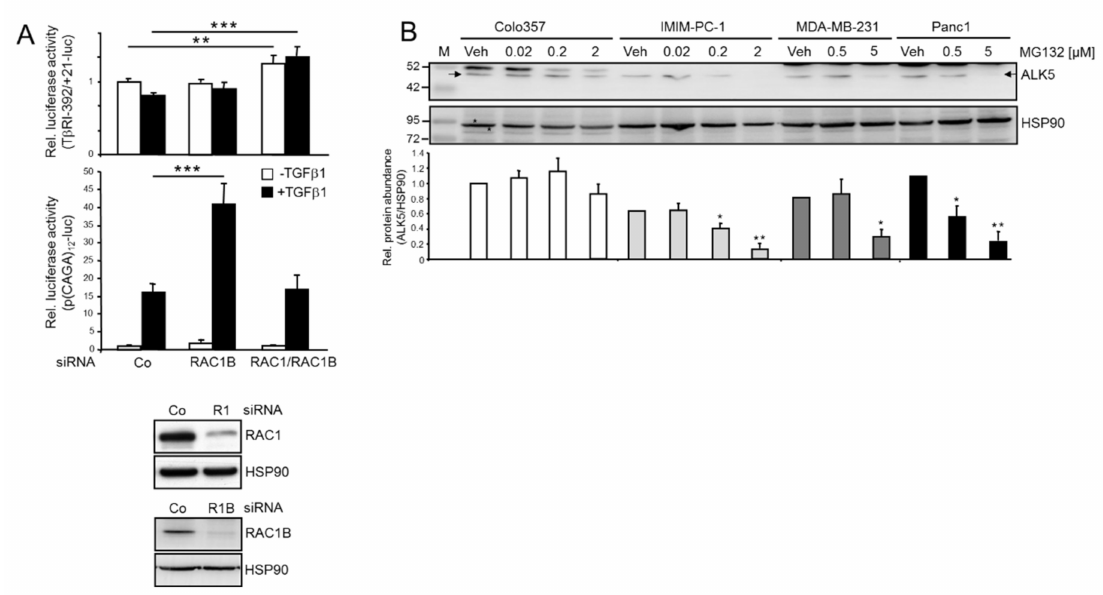
Figure 1. Negative regulation of ALK5 by RAC1B may involve regulation of ALK5 stability rather than downregulation of TGFBR1 promoter activity. ( A ) Panc1 cells were cotransfected with 100 ng of either T β RI-392 /+ 21-luc (upper graph) or p(CAGA) 12 -luc (lower graph), 25 ng pRL-TK-luc and 50 nM of either control (Co) siRNA, RAC1B siRNA or RAC1 siRNA (targeting both RAC1 and RAC1B). Then, 24 h later, cells were stimulated with TGF β 1 (5 ng / mL) for 24 h and subsequently processed for dual luciferase assay. Luciferase data (the mean ± SD of six parallel wells corrected for transfection e ffi ciency with Renilla luciferase) are from a representative experiment performed three times. The asterisks indicate significance. The blots underneath the graphs show successful knockdown of RAC1 (R1) and RAC1B (R1B). ( B ) The PDAC cell lines Colo357, IMIM-PC-1 and Panc1, and the TNBC cell line MDA-MB-231 were treated for 24 h with the indicated concentrations of the proteasome inhibitor MG132, or vehicle (Veh) and subsequently processed for immunoblotting of ALK5 (specific band marked by arrows) and HSP90 as a loading control. The graph below the blot depicts data from densitometric readings of band intensities from underexposed autoradiographs and represents the mean ± SD of three experiments. Data are plotted relative to the respective Veh treated control cells set arbitrarily to 1.0. Significant di ff erences ( p < 0.05, two-tailed unpaired Student’s t -test) relative to the corresponding vehicle-treated control are indicated by an asterisk. M, molecular weight